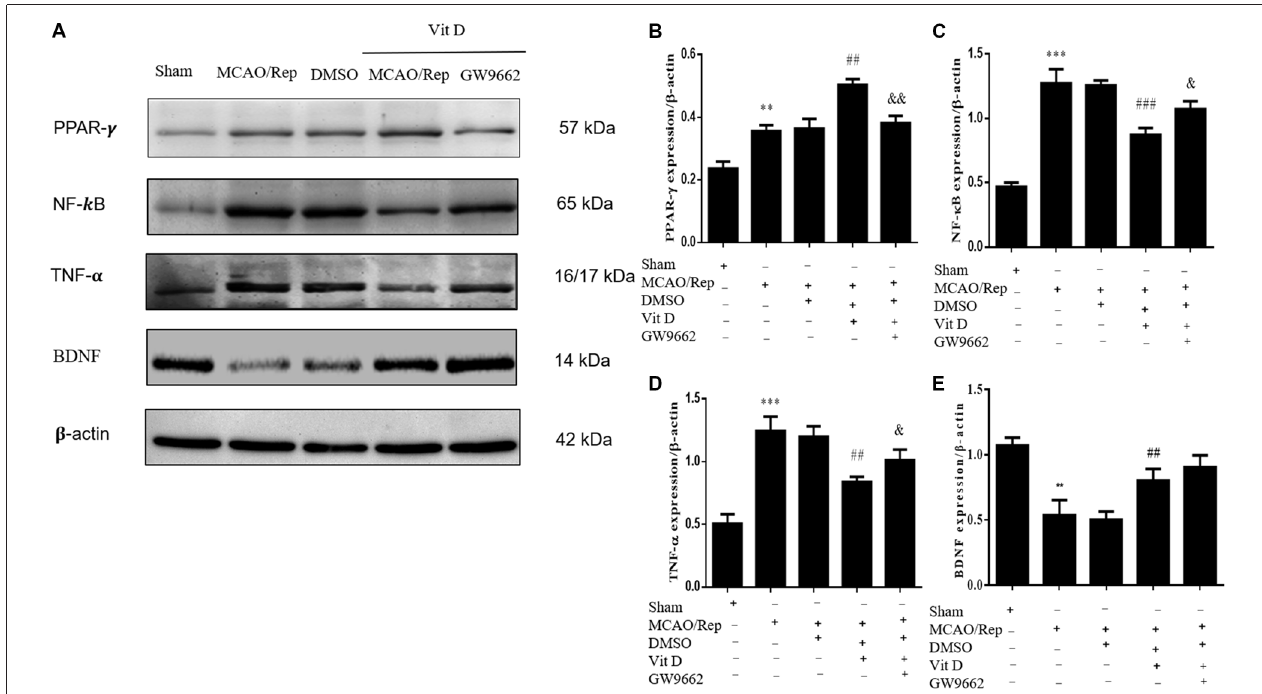
FIGURE 6 | 1, 25-D 3 (Vit D) pre-treatment suppressed the MCAO/R-induced inflammatory response by activating PPAR- γ . (A) The representative image of western-blot analysis for PPAR- γ , TNF- α , NF- κ B and BDNF. (B–E) PPAR- γ , TNF- α , NF- κ B and BDNF expression levels in the brain tissues of different groups were analyzed by Western blotting. Data are represented as mean ± SEM, n = 6, ∗∗∗ P < 0.001 vs. sham group, ∗∗ P < 0.01 vs. sham group, ### P < 0.001 vs. DMSO, ## P < 0.01 vs. DMSO, && P < 0.01 vs. 1, 25-D 3 group, & P < 0.05 vs. 1, 25-D 3 group. MCAO/R, middle cerebral artery occlusion/reperfusion; 1, 25-D 3